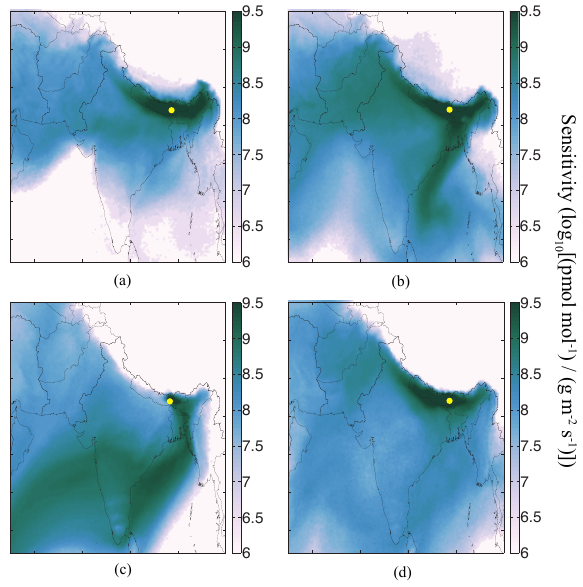
Fig. 2. Monthly median air histories for (a) January 2012 (b) April 2012 (c) July 2012 (d) October 2012. Color bar is a logarithmic scale showing the sensitivity of Darjeeling (yellow dot) mole frac- tions in pmol mol − 1 to emissions of any inert gas in g m − 2 s − 1 .